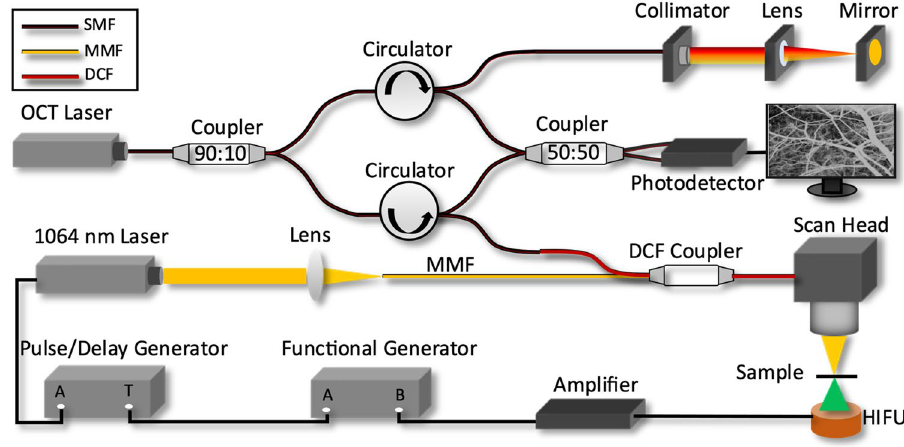
Figure 4. Schematic of OCTA-guided PUT system. DCF double clad fiber, SMF single mode fiber, HIFU high intensity focused ultrasound, MMF multimode fiber.